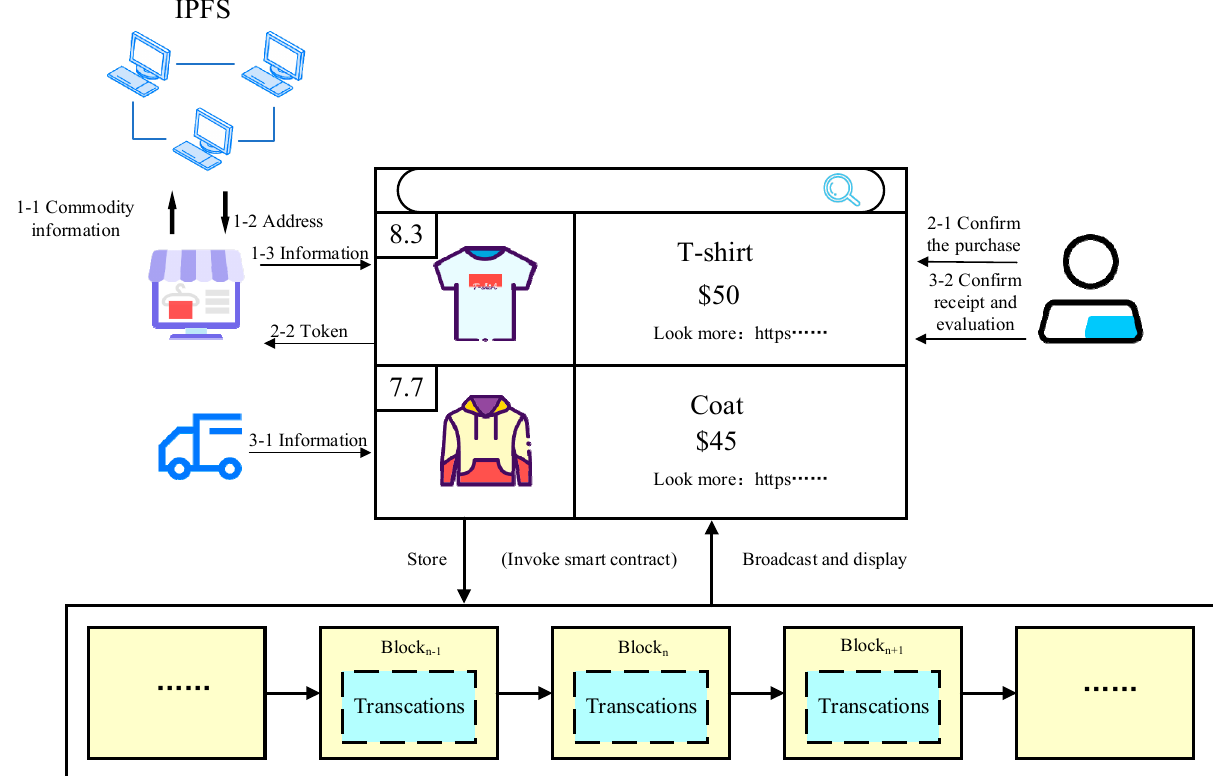
Figure 3. E-commerce system platform